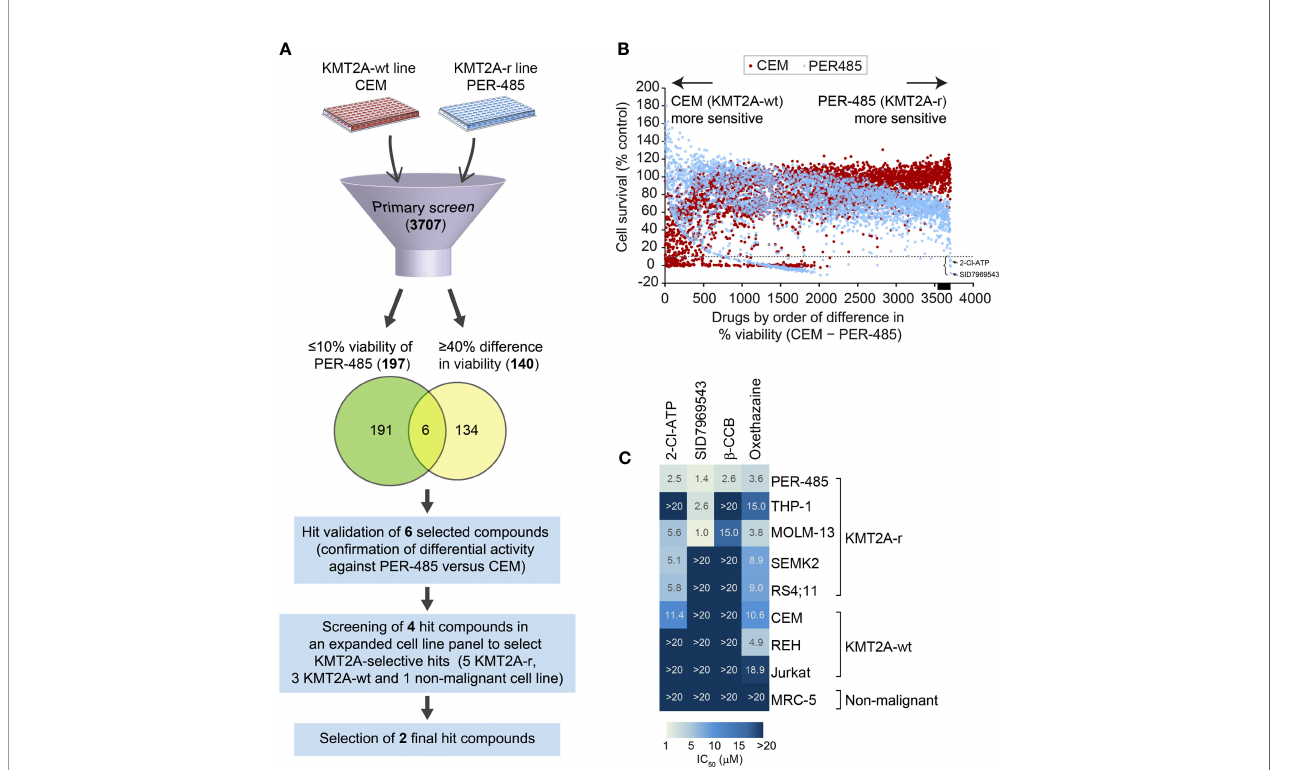
FIGURE 1 | Cell-based screening for identi fi cation of selective inhibitors of KMT2A-r leukemia. (A) Schematic of the drug screen. (B) Percentage viability of KMT2A- wt CEM and infant KMT2A-r PER-485 cell lines represented by a dot plot after primary screening of the 3707-compound library. Each dot represents the viability of the speci fi ed cell line (CEM, red; PER-485, blue) after treatment with an agent (5 m M) from the compound library. Compounds are arranged on the x-axis according to the difference in growth inhibition of PER-485 cells compared to CEM cells (%viability of CEM – %viability of PER-485). Compounds showing higher inhibitory effects in PER-485 than in CEM are displayed towards the right of the x-axis, whereas compounds that CEM are more sensitive to compared with PER-485 are towards the left. The dotted line indicates 10% cell viability. The black bar on the x-axis indicates the position of the 140 drugs that have ≥ 40% difference in viability (%viability of CEM – %viability of PER-485 ≥ 40%). The left curly bracket indicates the position of the six hit candidates selected for further evaluation in expanded cell line panels. The black arrows indicate the achieved PER-485 %viability values corresponding to the two fi nal hit compounds selected from the screen. (C) Heatmap of concentration with 50% cell growth reduction (IC 50 ) achieved in different cell lines after treatment with 5 m M of each compound for 72